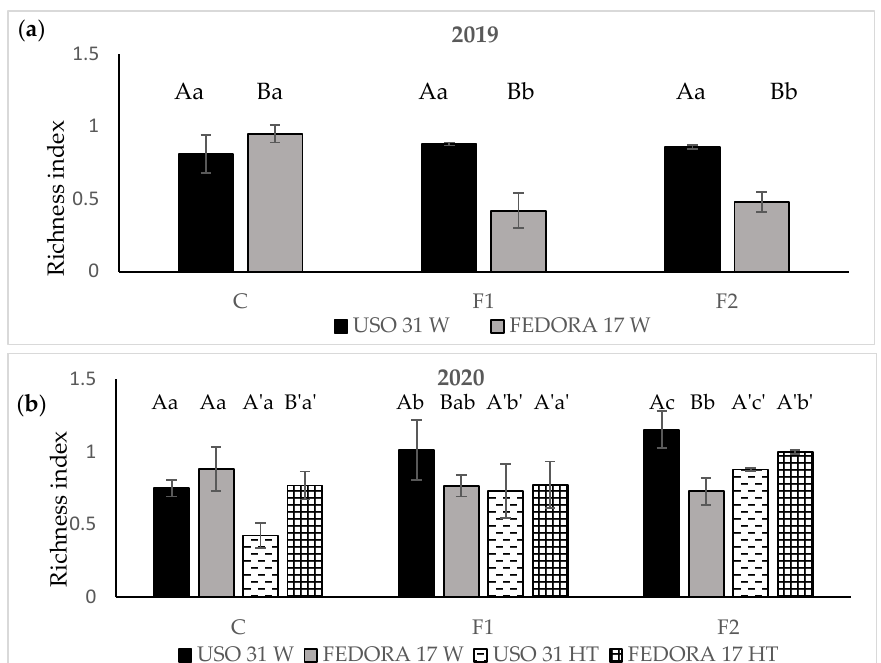
Figure 6. Richness index of weeds in hemp crop during the growing season 2019 ( a ) and during the growing season 2020 ( b ). Vertical bars indicate the standard errors of the means. Values without a common le tt er are statistically signi fi cant according to LSD (0.05).